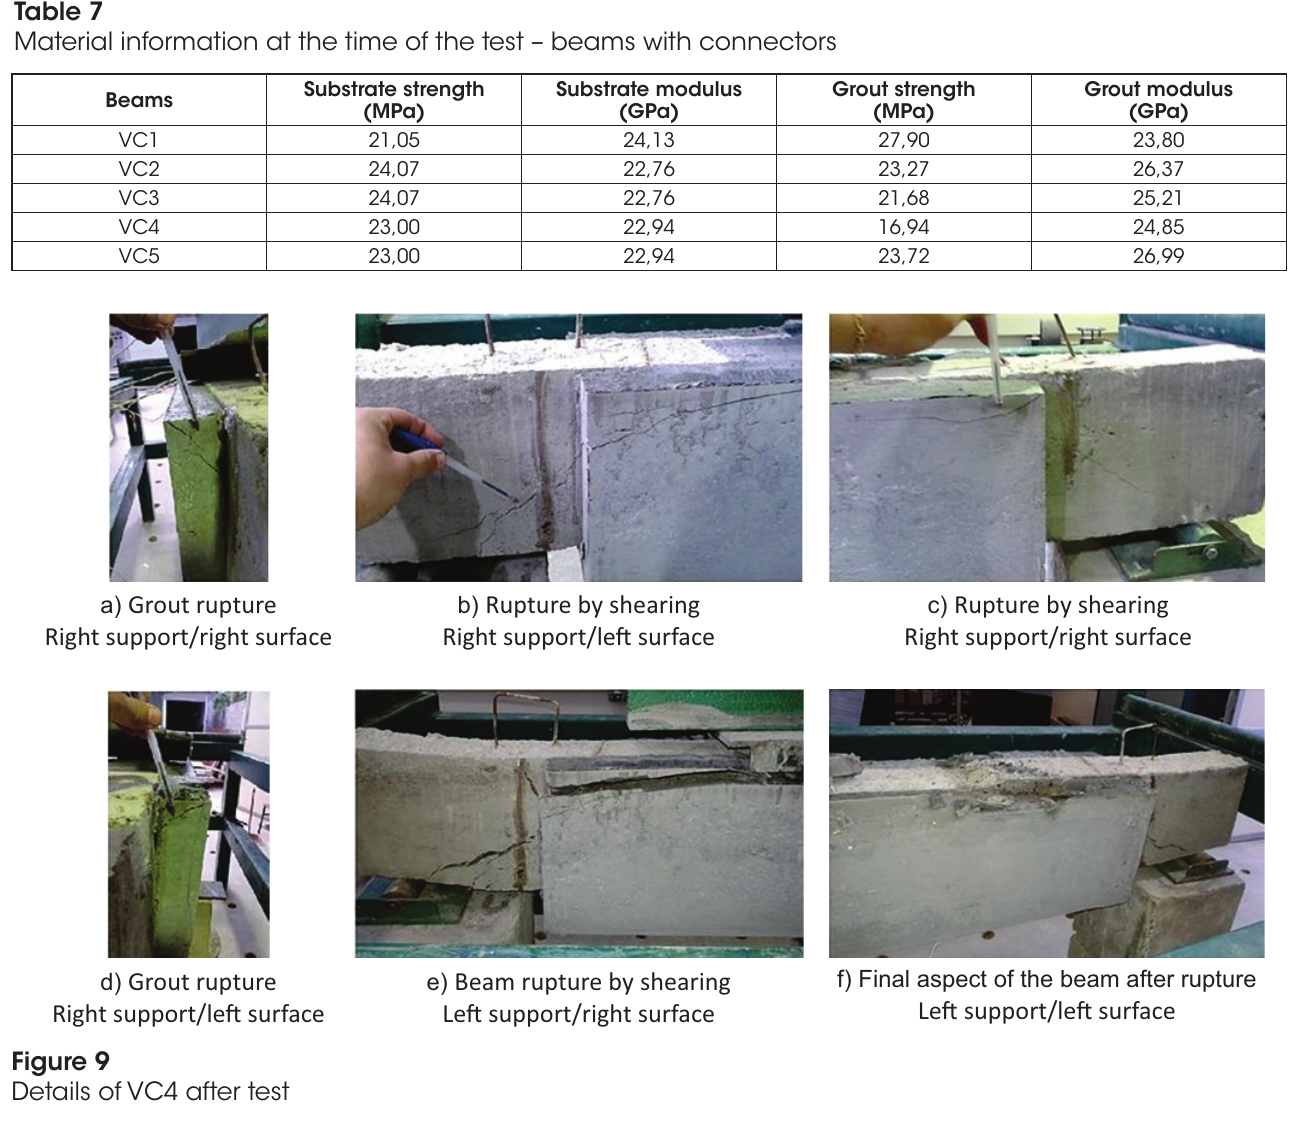
d) Grout rupture Right support/le� Details of VC4 after test